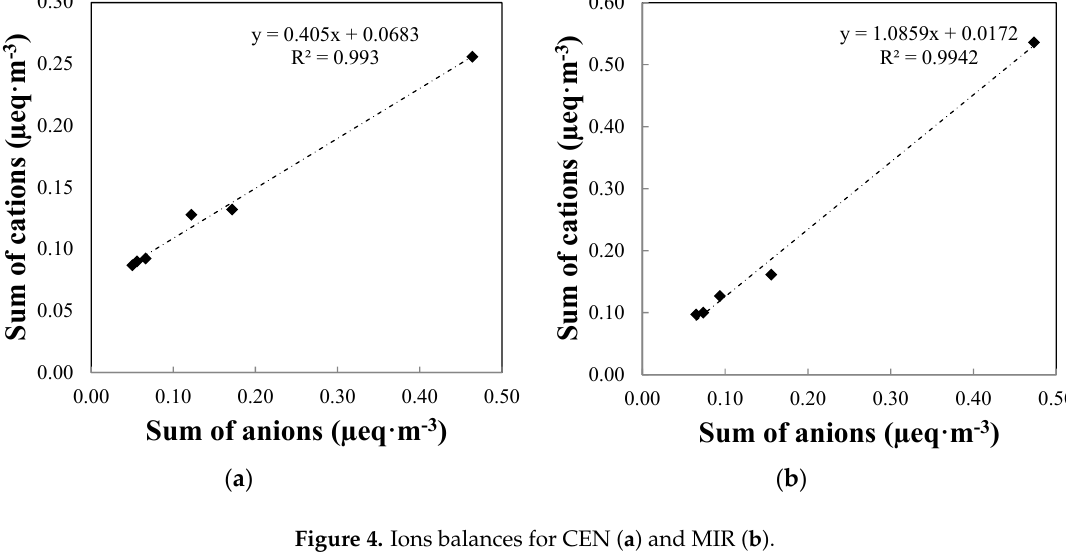
Figure 4. Ions balances for CEN ( a ) and MIR ( b ).